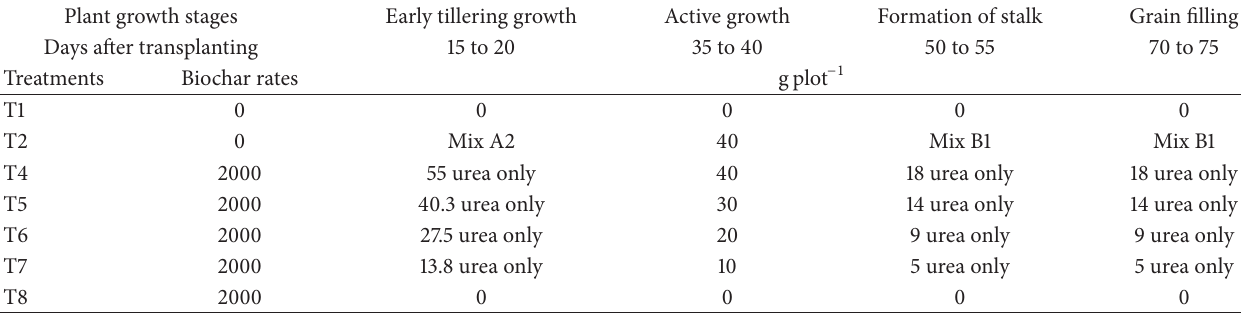
Table 4: Biochar rate and fertilization schedule of the field